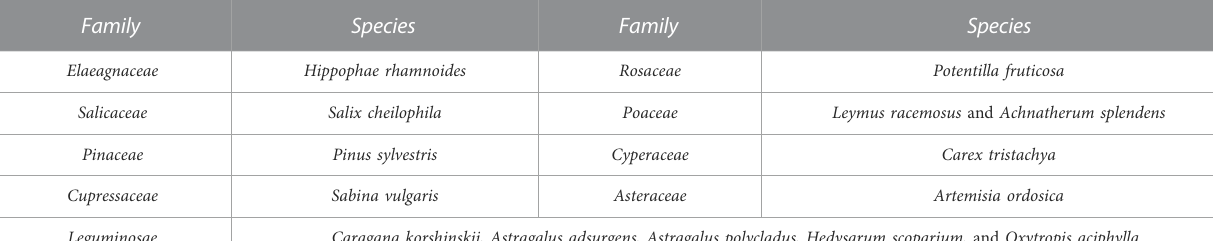
TABLE 2 Species composition of plant communities on the sites (in accordance with family classi fi cation).